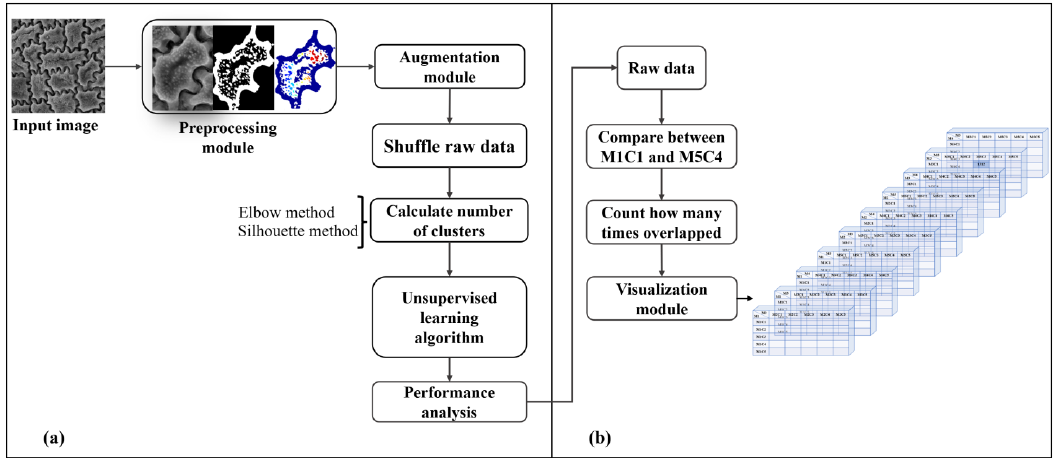
Figure 8. Proposed algorithm for this study. ( a ) General module, ( b ) Performance analysis module.